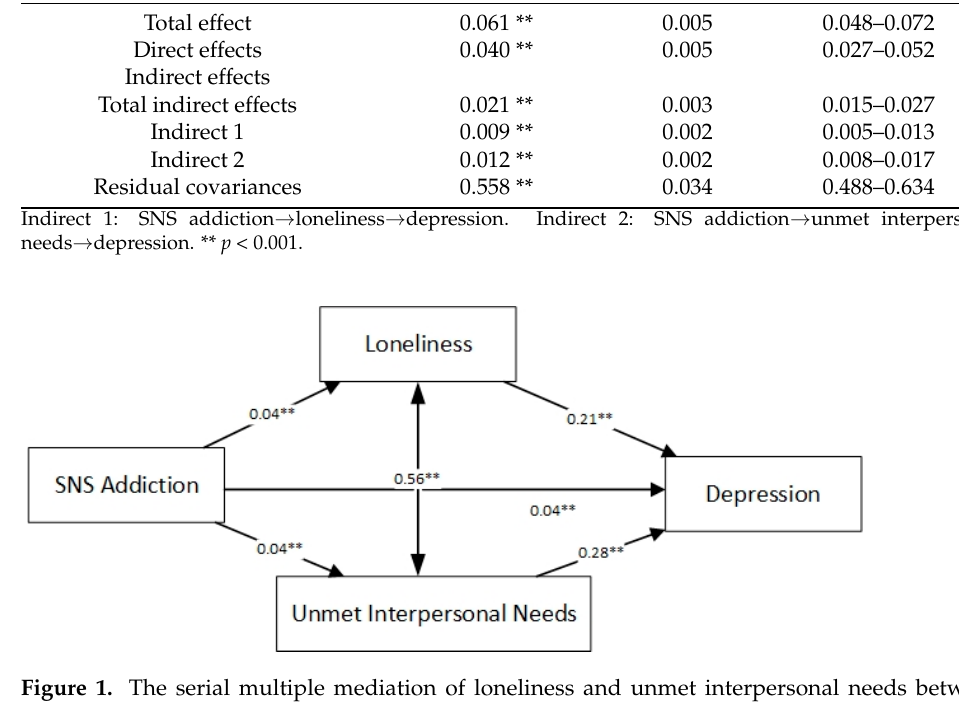
Table 4. The mediation of loneliness and interpersonal needs between SNS addiction and depression. Path